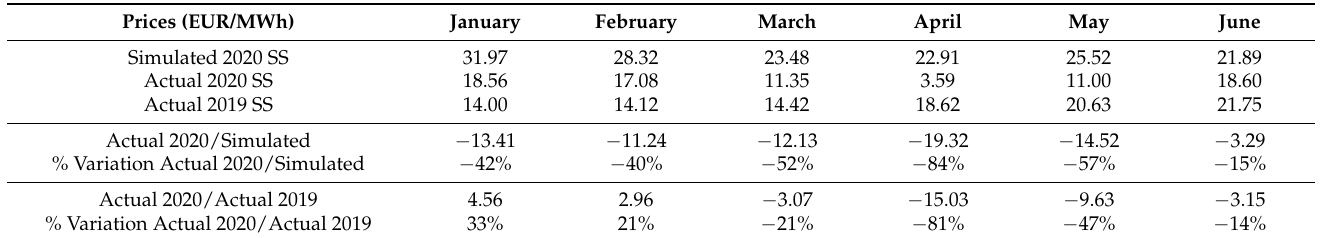
Table 6. Actual SS for first half of 2019 and 2020 and expected SS for the first half-year of 2020.